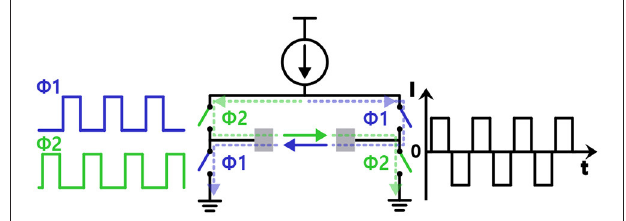
Frontiers in Neuroscience |